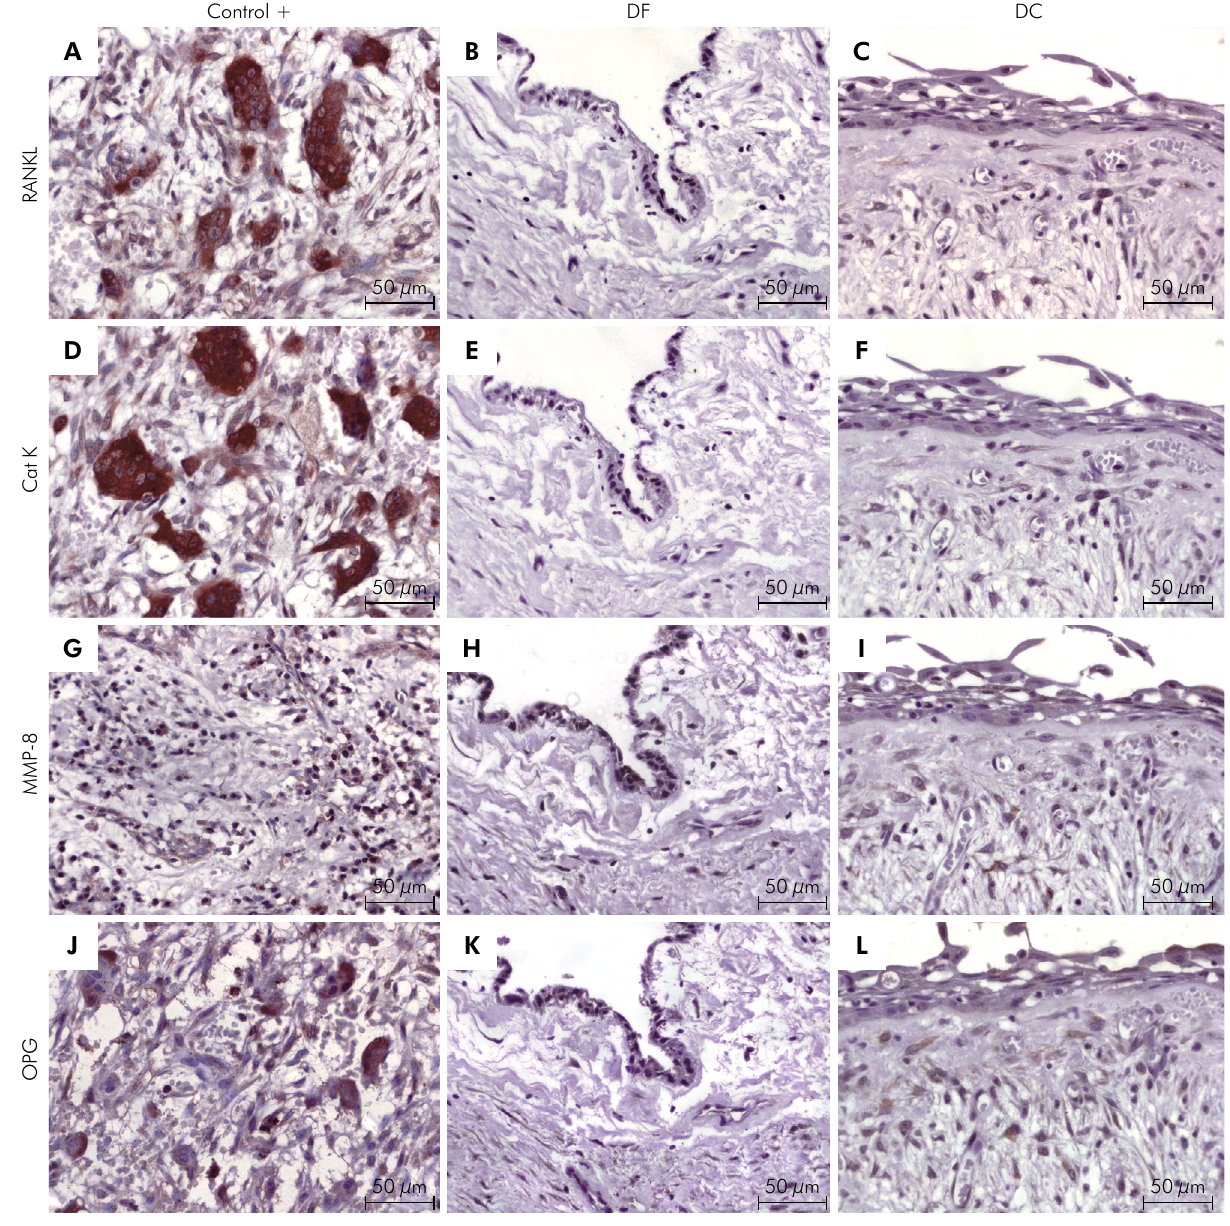
Figure 1. Immunoexpression of RANKL, CatK, MMP8 and OPG in dental follicle (DF), dentigerous cyst (DC), and positive control (A, D and J: central giant cell lesion, G: radicular cyst). Note the absence of expression of RANKL (B) and CatK (E) in DF and weak expression in the cystic epithelium and capsule of DC (C and F). Expression of OPG is more evident in the cytoplasm and nucleus of epithelial and mesenchymal cells of DF (K) and DC (L). MMP8 present in the cytoplasm and nucleus of mesenchymal cells of DF